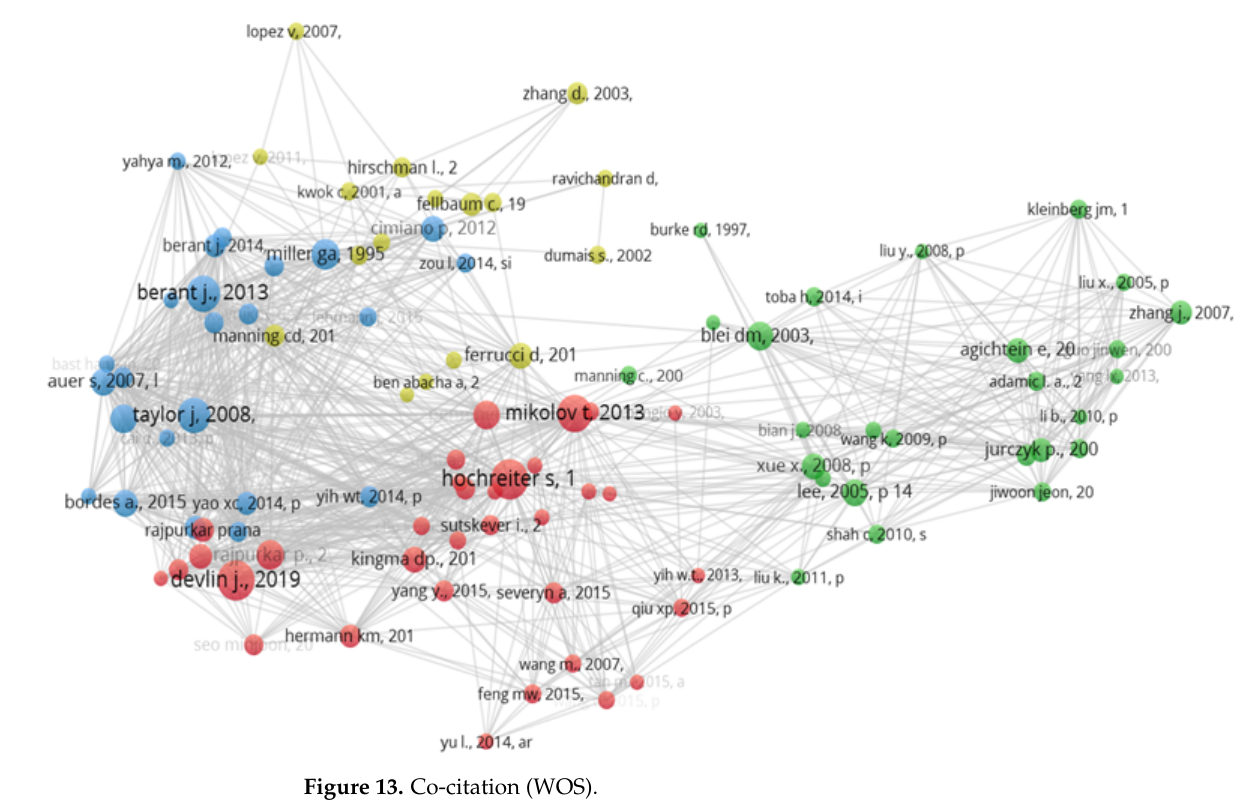
Figure 13. Co-citation (WOS). Table 8. Co-citation analysis strategy.